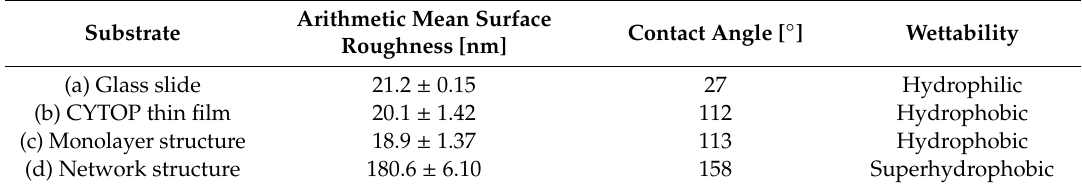
Figure 7. Contact angle measurements of ( a ) glass slide, ( b ) CYTOP thin film, ( c ) monolayer, and ( d ) network structures of CYTOP NPs deposited onto glass slides. Table 2. Morphology and wettability measurements of each substrate.